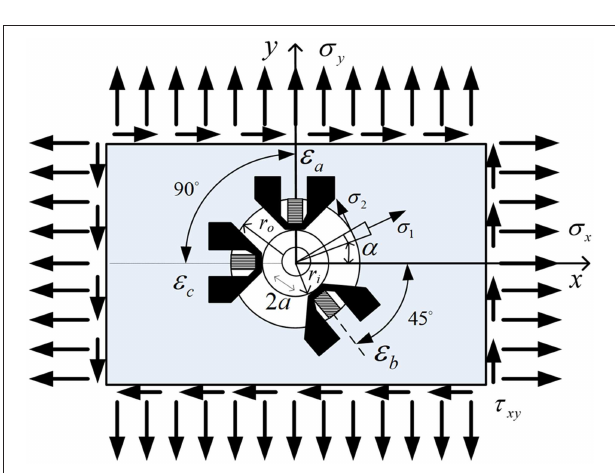
FIGURE 2 | Stress state near the drilling hole (Duvnjak et al.,